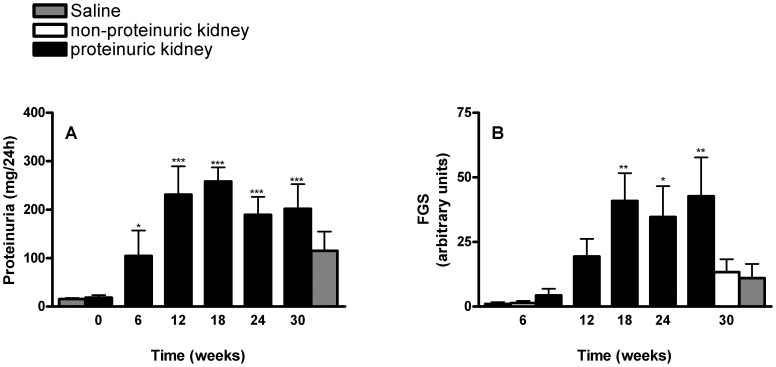
Development of proteinuria (A) and focal glomerulosclerosis (B) over time in unilateral Adriamycin-induced nephropathy.(*p<0.05, **p<0.01, ***p<0.001); (A) versus week 0; (B) versus week 6.